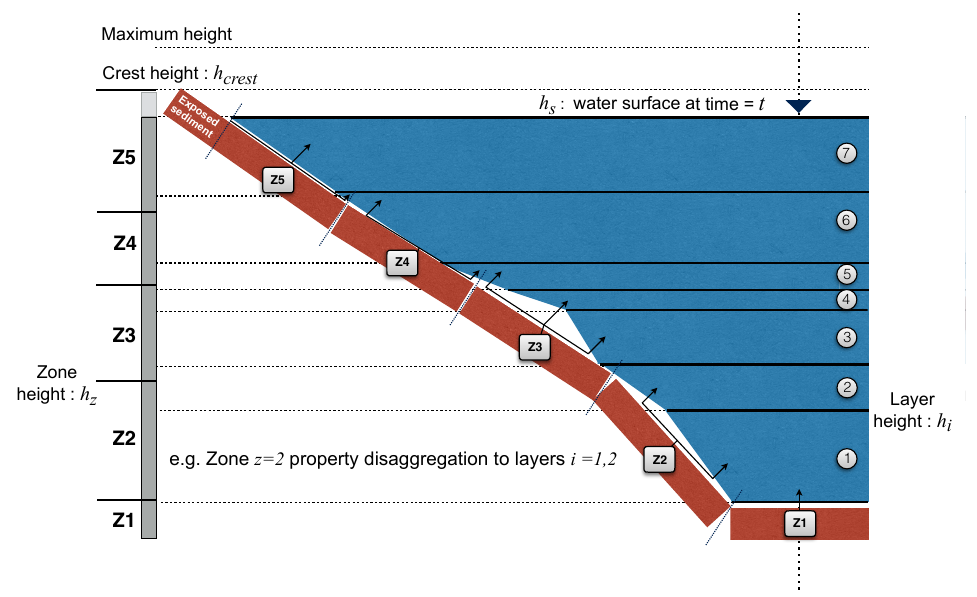
Figure 18. Schematic of a lake model layer structure (indicated by layers i = 1 : 7), in conjunction with five sediment “zones” (Z1–Z5) activated when benthic_mode = 2. The dynamically varying layer structure is remapped to the fixed sediment zone locations at each time step in order for the sediment zone to receive the average overlying water properties and for the water to receive the appropriate information from benthic–sediment